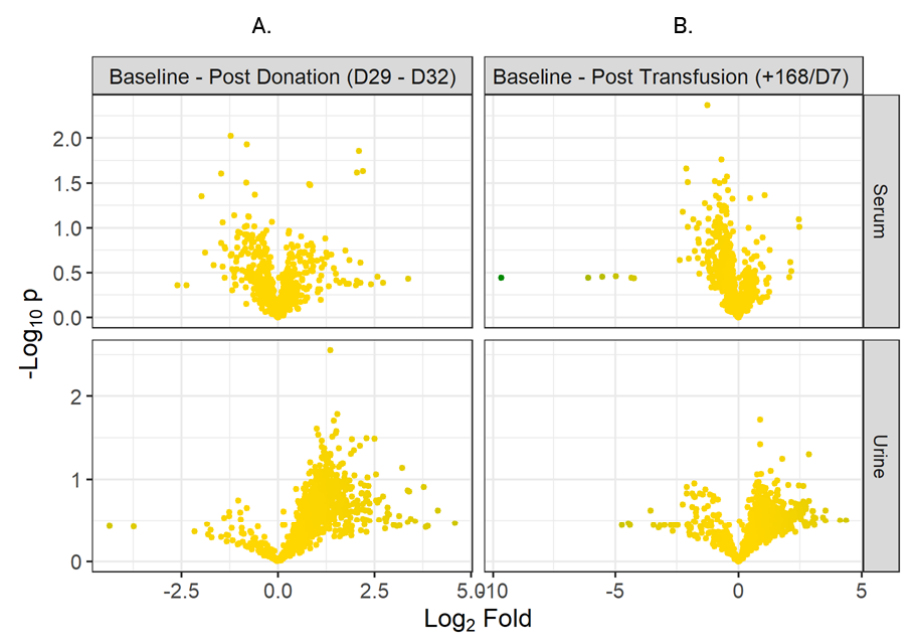
Figure 2. Volcano Plots ( A ) comparing Baseline vs. Post-donation (D29–32) in serum and urine, ( B ) comparing Baseline vs. Post-transfusion (+168 h) in serum and urine. Table 1. Phthalates identified in urine in post-donation and post-Transfusion phases.